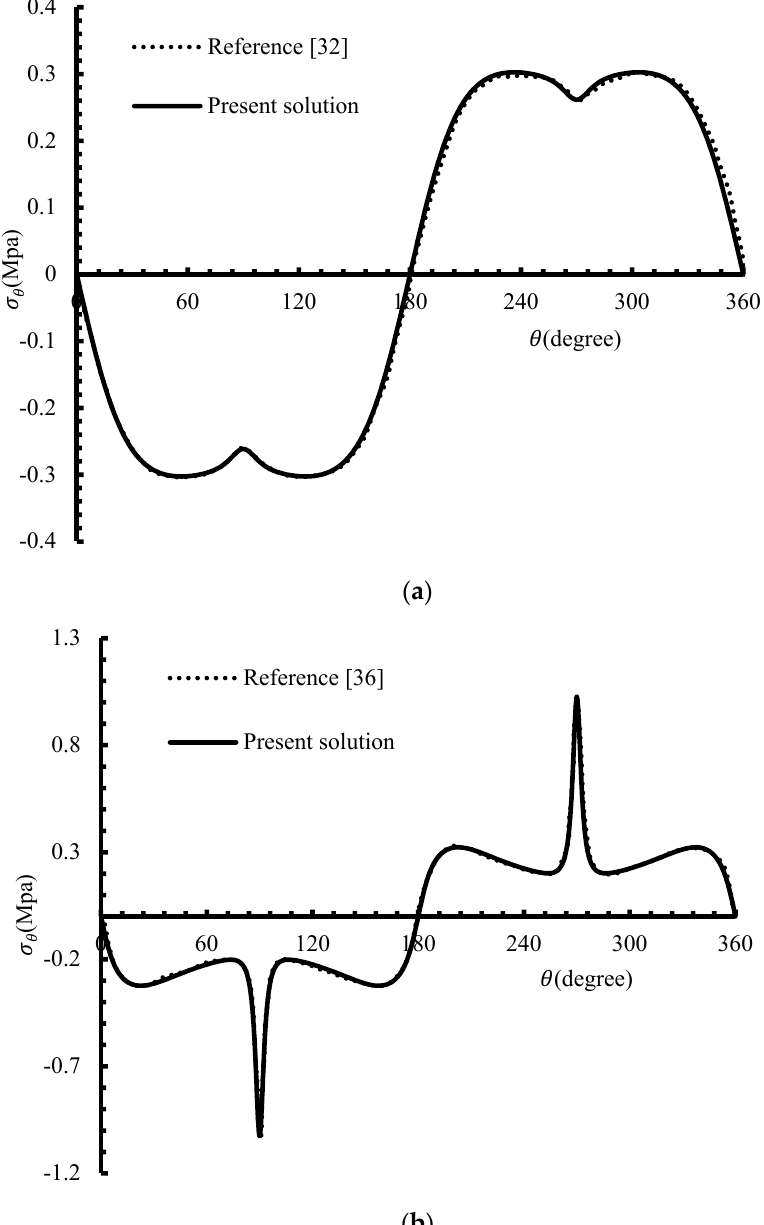
Figure 5. Comparison between the present solution and other researchers’ results, ( a ) Ref. [32], ( b ) Ref. [36].